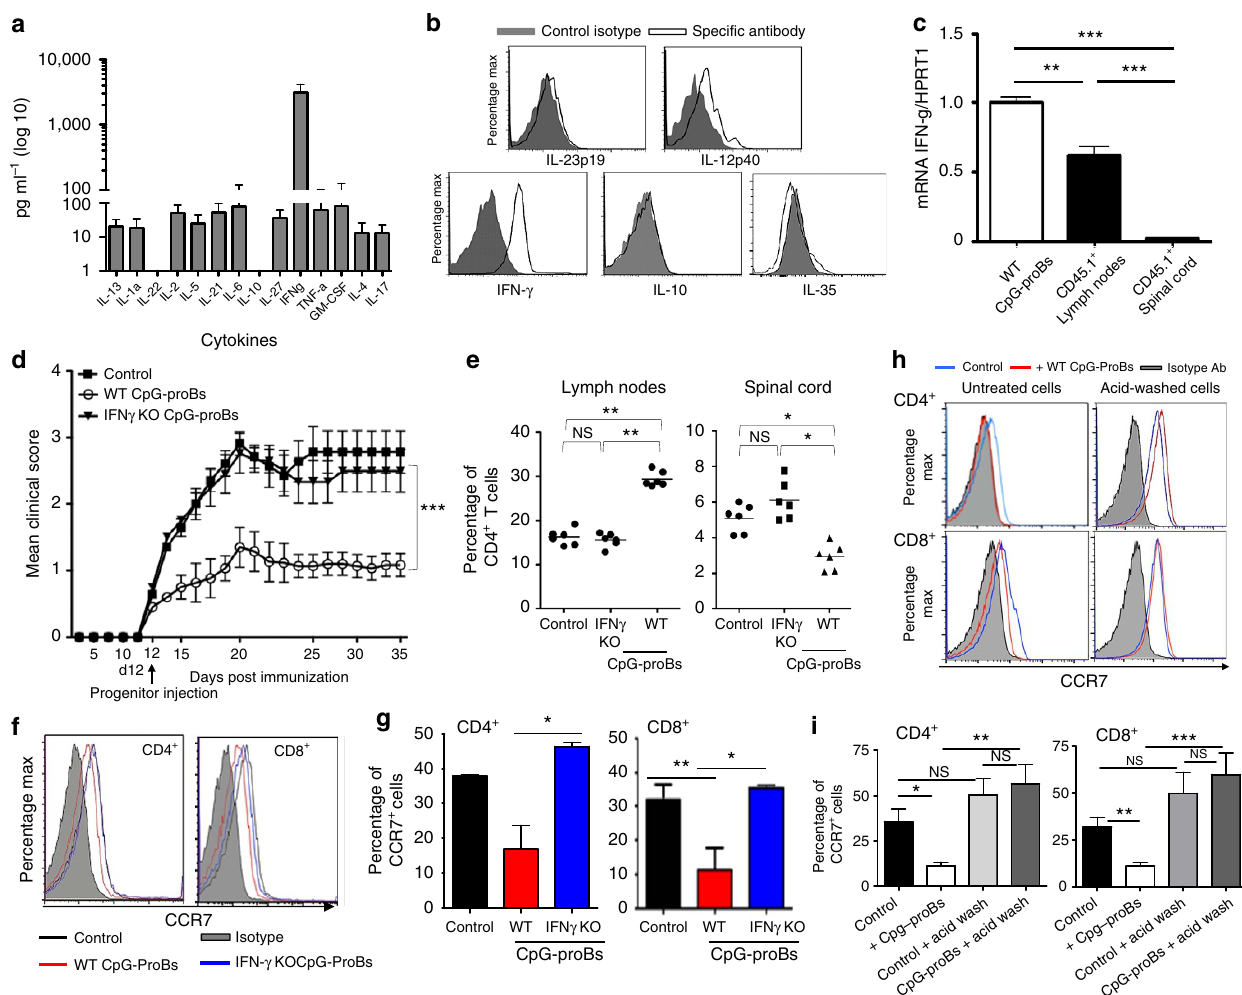
Figure 5 | Role of IFN- c in the protective properties of CpG-proBs. ( a ) Cytokine level determination by multiplex ELISA for Th1/Th2/Th17 cytokines and GM-CSF (expressed in pgml (cid:2) 1 ) in supernatants of CpG-proB cells (50,000 cells per 200 m l) stimulated for 5h with PMA þ ionomycin. ( b ) Constitutive cytokine production by WT CpG-proB cells. Immediately after FACS sorting, WT CpG-proB cells were stained for intracytoplasmic production of cytokines IL-23p19, IL-12p40, IFN- g , IL-10 and IL-35 using specific antibodies (open histograms) or isotype controls (filled histograms). ( c ) IFN- g mRNA levels relative to HPRT1, as determined by qRT–PCR in WT CpG-proBs, their CD45.1 þ progeny recovered from reactive LN or from spinal cord. Values are expressed as mean ± s.e.m. of three experiments ( d ) EAE clinical score (mean ± s.e.m.) in control mice ( n ¼ 30) and mice injected at day 12 of the disease with 60,000WT ( n ¼ 30) or IFN- g (cid:2) / (cid:2) CpG-proB cells ( n ¼ 20). Data are pooled from two independent experiments. *** P o 0.001 when comparing disease scores for control mice with those obtained after treatment with WT CpG-proB cells by two-way repeated measures ANOVA test. ( e ) Frequency of CD4 þ T cells found in reactive LN and spinal cord of control mice versus mice transferred WT or IFN- g (cid:2) / (cid:2) CpG-proB cells, n ¼ 6 mice per group, * P o 0.05 (Students’ t -test). ( f – g ) Expression of CCR7 analysed by flow cytometry in CD4 þ and CD8 þ cells from reactive LN of control mice with EAE versus mice transferred either WTor IFN- g (cid:2) / (cid:2) CpG-proB cells. Shown are a representative experiment ( f ) and the mean ± s.e.m. of the percentages of CCR7-positive CD4 þ and CD8 þ cells out of four experiments ( g ). ( h , i ) Expression of CCR7 analysed by flow cytometry either in untreated cells or after an acid wash and shown in a representative experiment ( h ) and as the mean ± s.e.m. of the percentages of CCR7-positive CD4 þ and CD8 þ cells out of three